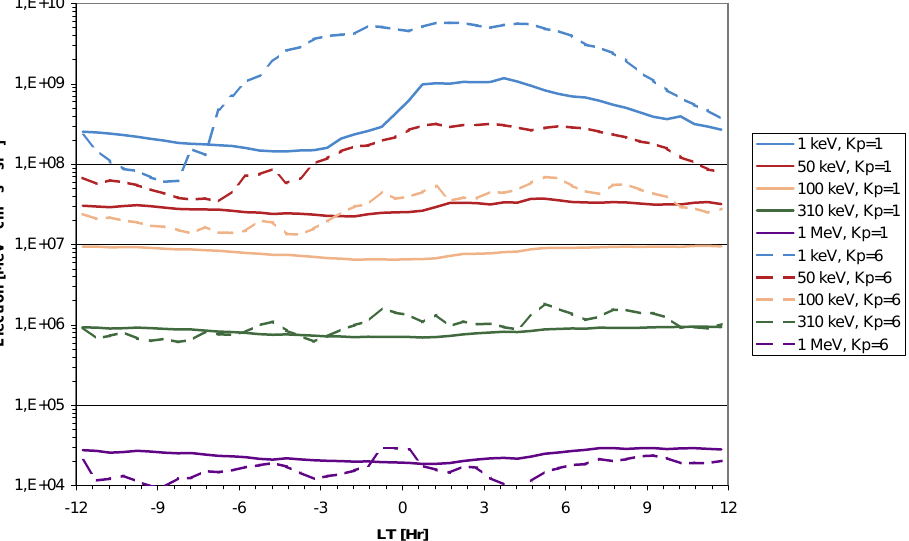
Fig. 8. Average electron flux at geostationary orbit for 1keV, 50keV, 100keV, 310keV and 1MeV versus local time for two magnetic activity index, Kp=1 and